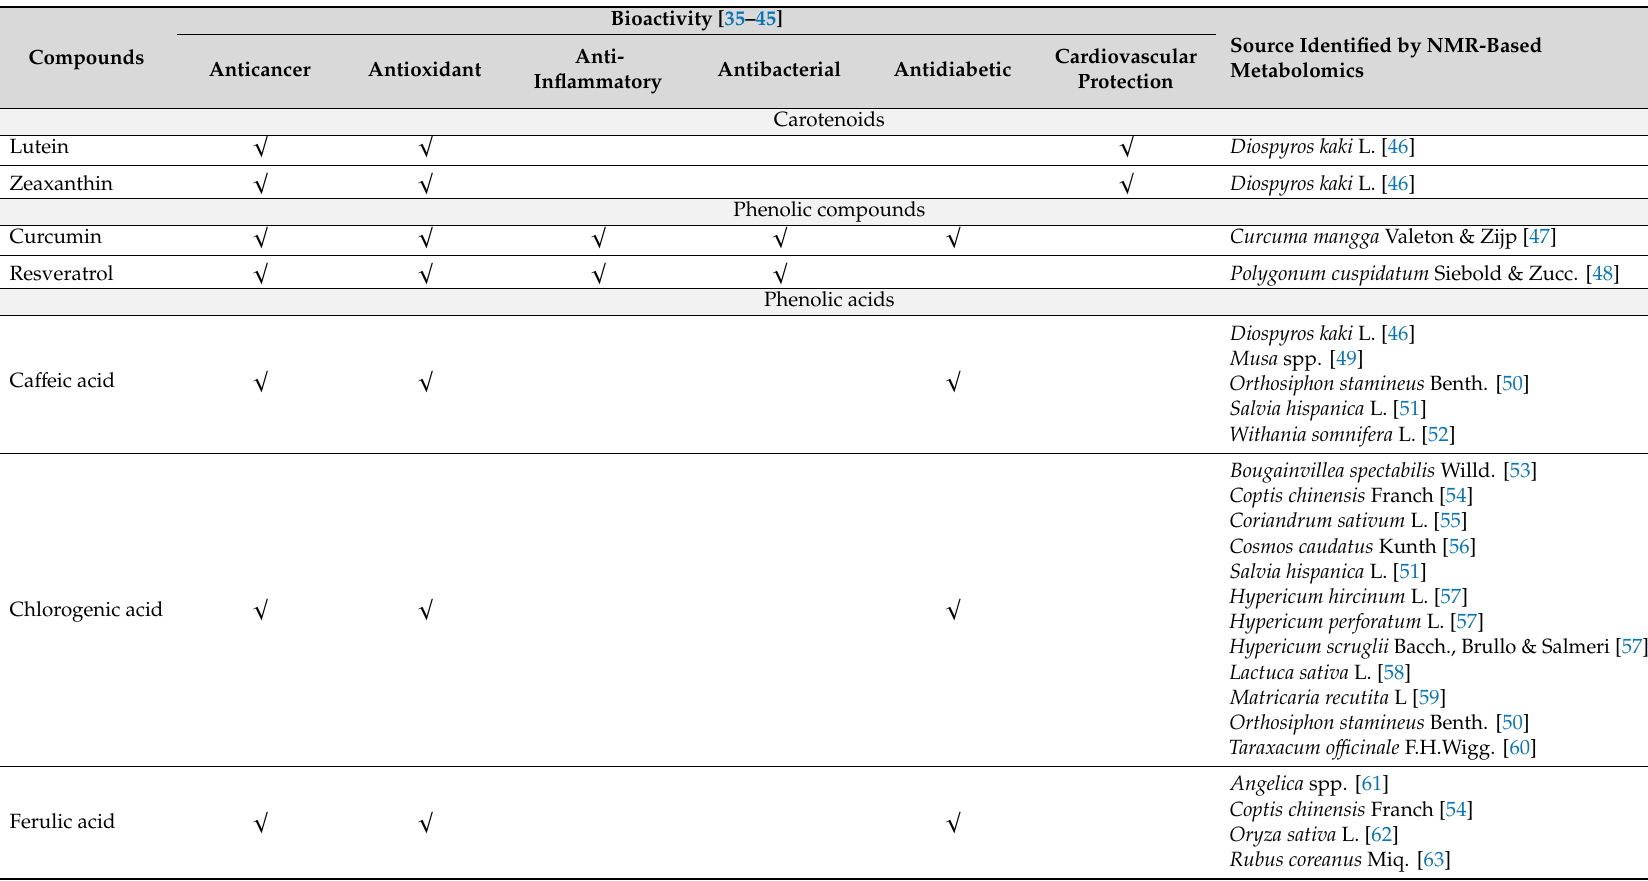
Table 2. Principal known nutraceuticals identified in extracts of di ff erent plant sources by 1D or 2D NMR-based